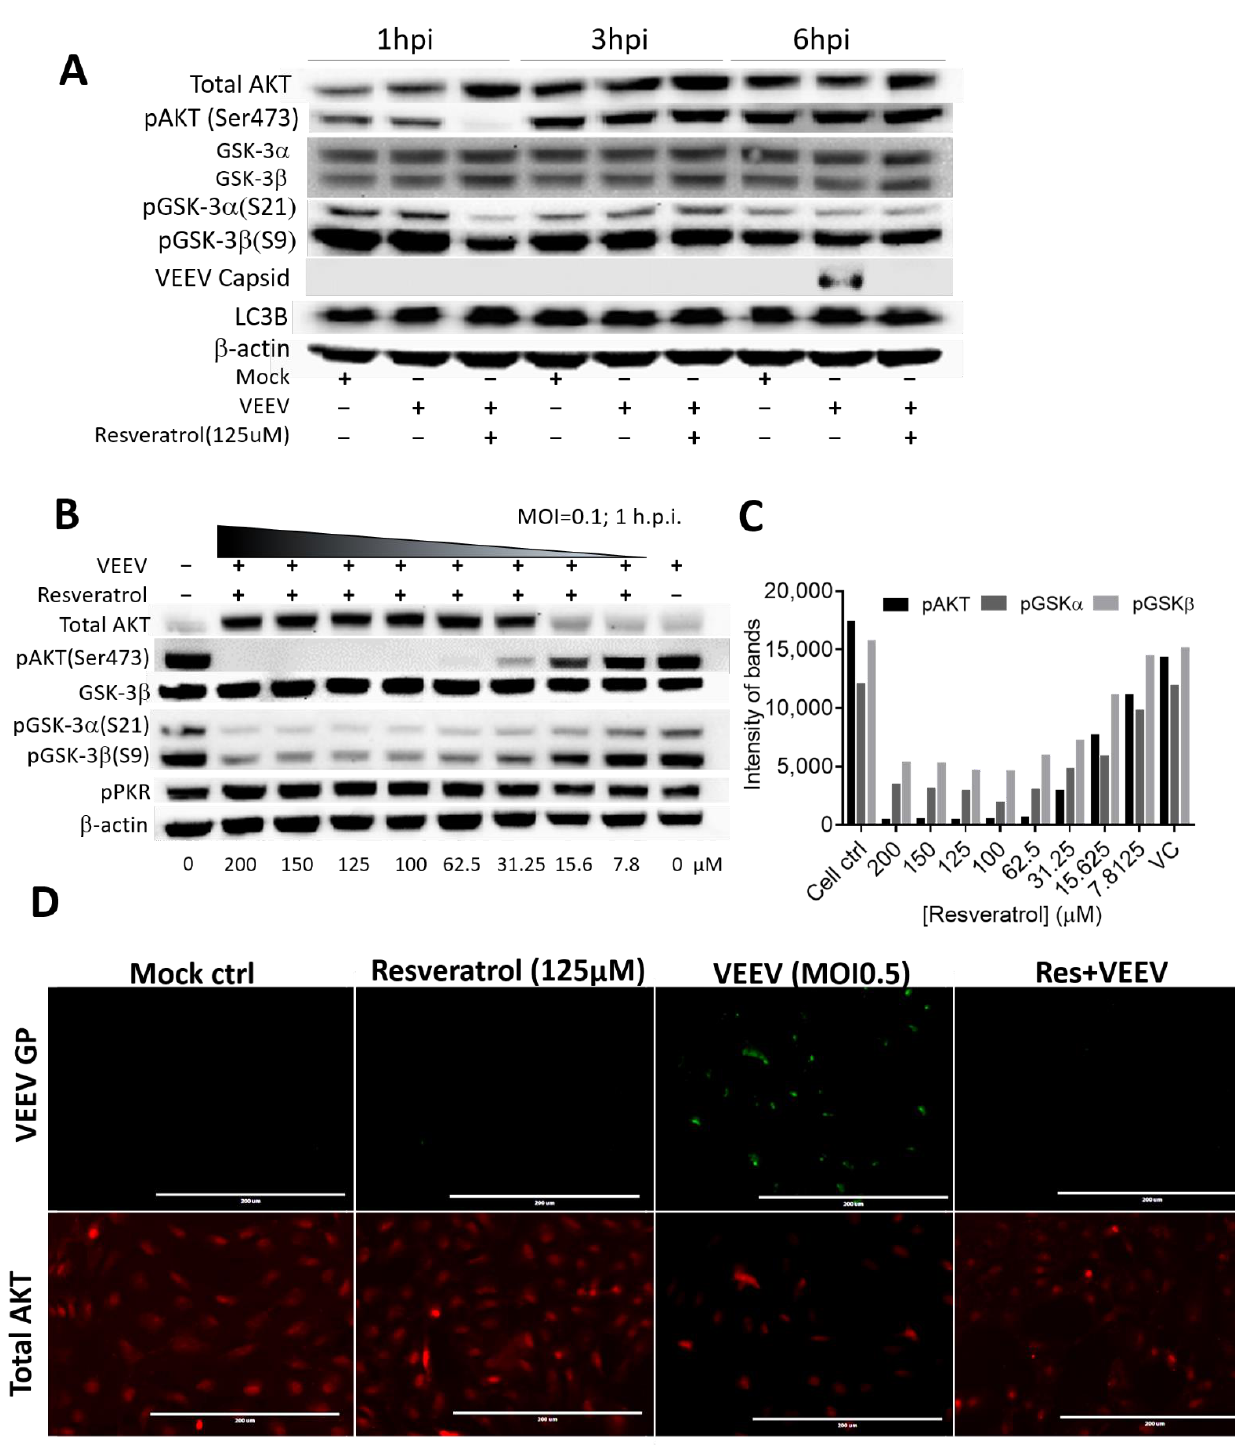
Figure 5. The AKT pathway in VEEV-infected cells after resveratrol treatment. ( A ) Indicated protein level changes in AKT signaling pathways tested at 1, 3, and 6 h.p.i. by Western blot analysis with or without 125 µ M of resveratrol along with VEEV-TC-83 infection at an MOI of 0.1. ( B ) The phosphorylation levels of AKT in VEEV-infected cells at 1 h.p.i. after resveratrol treatment at various concentrations and ( C ) the band intensities of AKT, GSK-3 α , and GSK-3 β were quantified with Quantity One analysis software from Bio-Rad Inc. ( D ) The fluorescent distributions of VEEV glycoprotein (GP) in green and cellular total AKT proteins in red were visualized in mock or VEEV-infected cells at an MOI of 0.5 and 4